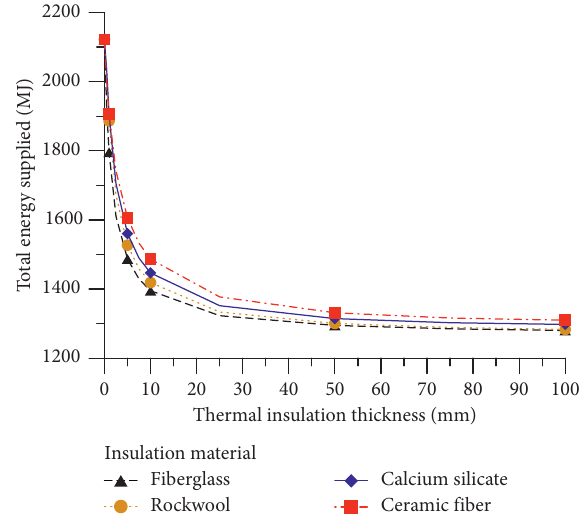
Figure 15: Total energy supplied as a function of the thermal insulation